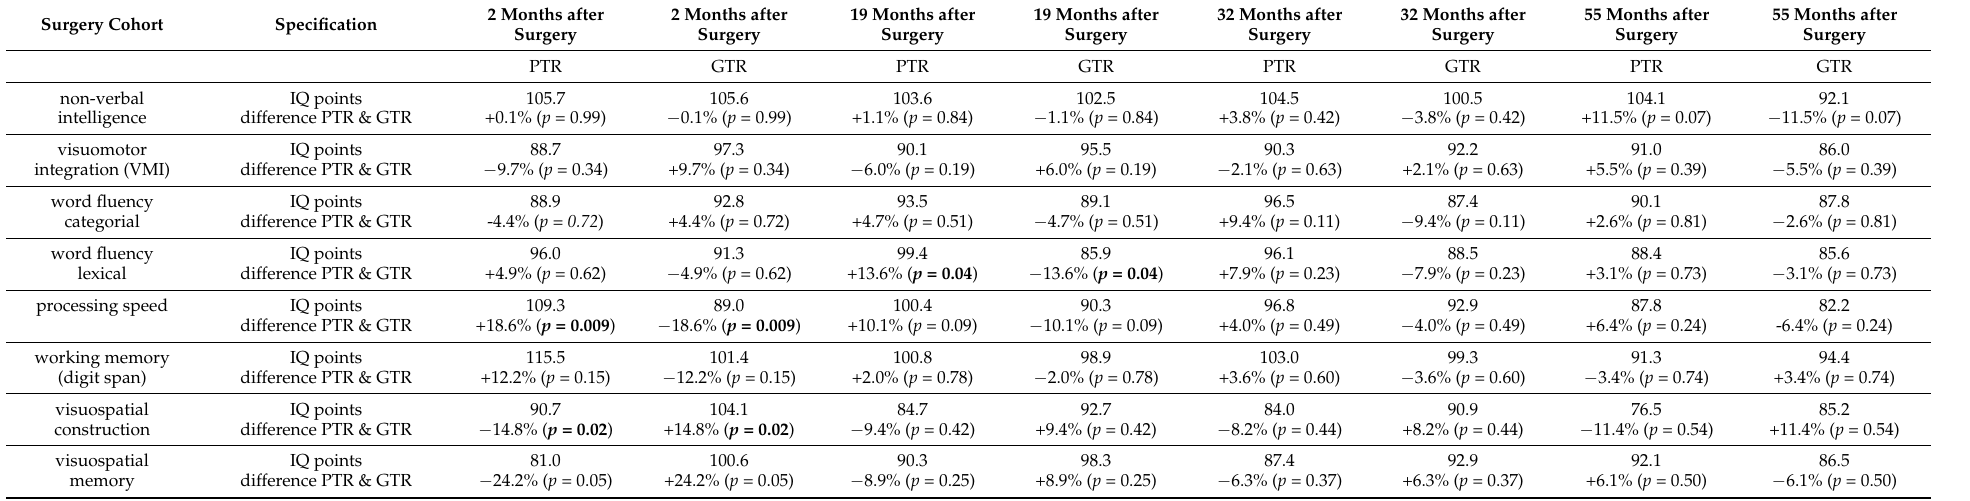
Table 4. Results of subgroup analysis. Comparison of neurocognitive outcome in eight different neurocognitive domains after partial tumor resection (PTR) versus gross total resection (GTR) in longitudinal